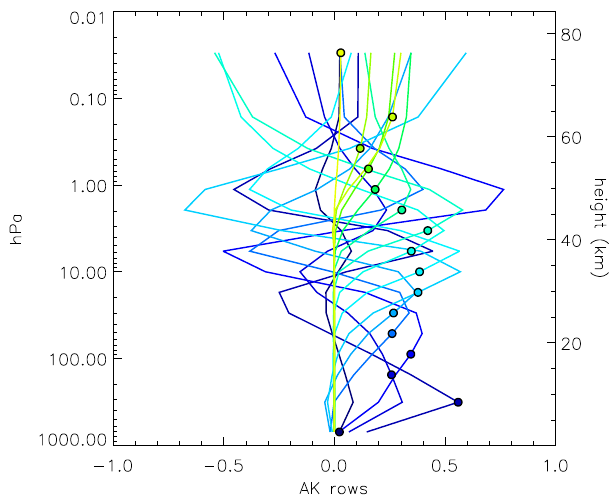
Fig. 5b. Averaging kernels for the 16-layer GOME retrieval over Europe that was also used for the blue line in Fig. 1. The circles give the nominal altitude for the retrieval. The averaging kernels corresponding to the albedo and the additive offset have not been plotted.